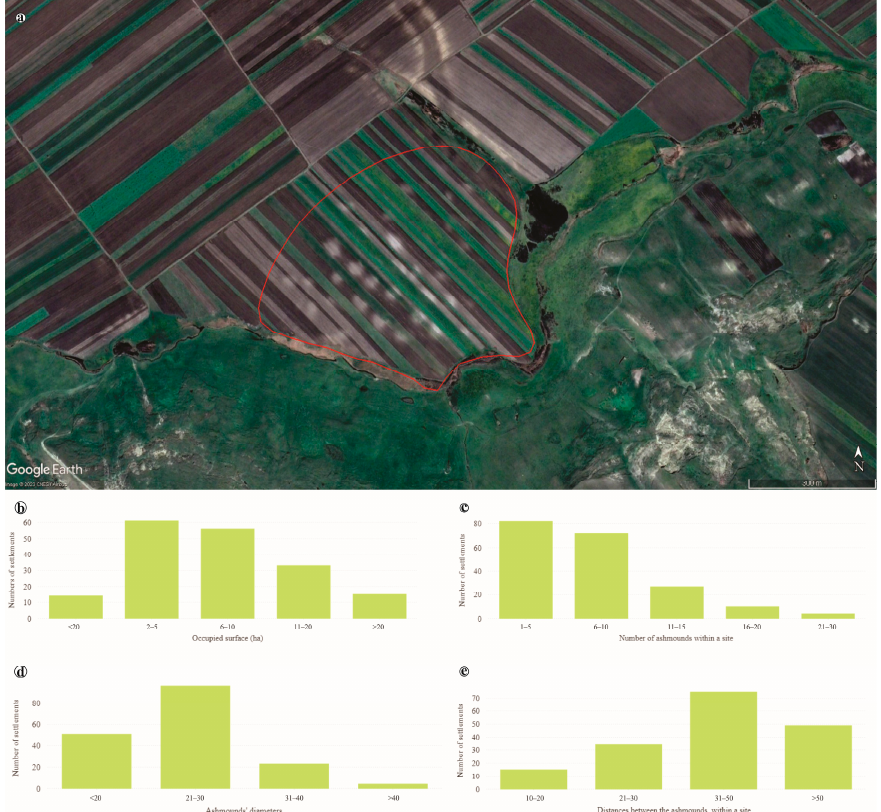
Figure 4. Analysis of the characteristics visible on satellite images: ( a ) exemplification of the manner in which we can identify a settlement with ashmounds on Google Earth Pro (image from 04.2018); ( b ) graph containing the statistical results of the sites’ area; ( c ) graph containing the statistical results of the number of ashmounds present within a site; ( d ) graph containing the statistical results of the ashmounds’ diameters; ( e ) graph containing the statistical results regarding the distances between ashmounds within a site.